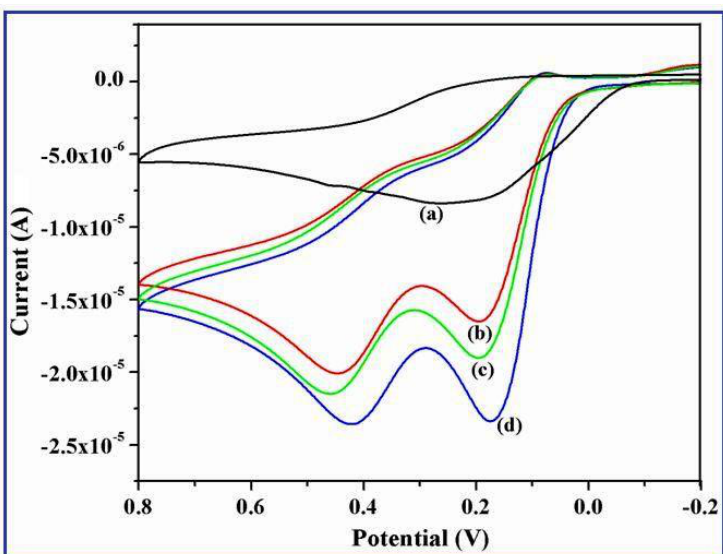
Figure 10. Simultaneous determination of 0.5 mM dopamine (DA) and uric acid (UA) using CV in 0.1 M PBS (pH 7.4) at a fixed scan rate of 50 mV/s ( a ) unmodified GCE, ( b ) γ -Fe 2 O 3 nanoparticle aggregates/GCE ( c ) γ -Fe 2 O 3 nanodots/GCE and ( d ) γ -Fe 2 O 3 nanobelts/GCE, respectively.